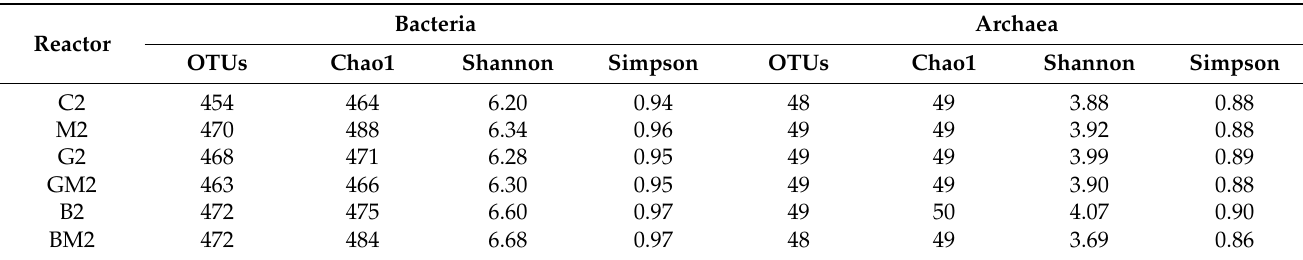
Table 1. Alpha diversity of microbial communities in the anaerobic reactors (sampled on day 6).